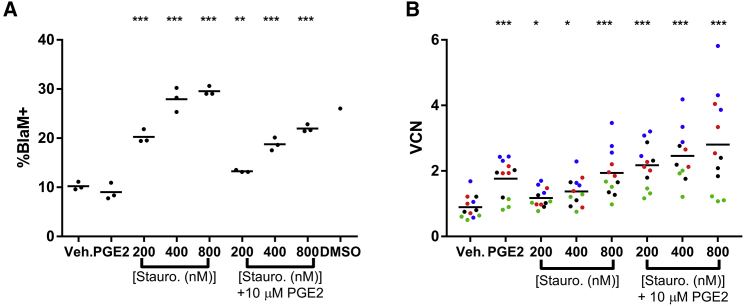
Combination Staurosporine and PGE2 Treatment Further Enhances Transduction of Human CD34+ Cells(A) CD34+ cells were treated for 2 hr with vehicle or staurosporine (200–800 nM) and then transduced with a BlaM-containing LVV for 2 hr in the presence of vehicle or 10 μM PGE2. Cells were then analyzed for presence of β-lactamase activity, indicating LVV entry. DMSO only = 5% DMSO as control for entry via cellular membrane permeabilization. (B) CD34+ cells were treated for 2 hr with vehicle or staurosporine (200–800 nM) and then transduced with a BlaM-containing LVV or BB305 LVV for 24 hr in the presence of vehicle or 10 μM PGE2. Pooled methylcellulose colonies were analyzed for VCN. Circles indicate individual replicates within an experiment; color indicates unique experiment. *p < 0.05, **p < 0.005, ***p < 0.0005, all compared to vehicle control.